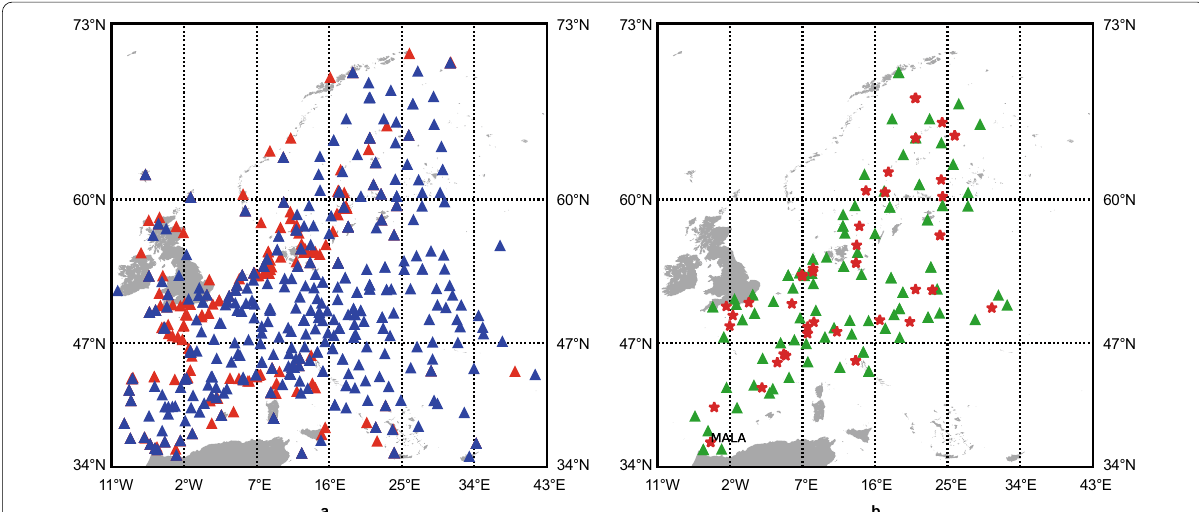
Fig. 2 The EPN [blue] and SONEL [red] networks in Europe provide PPP-RTK service in ( a ). In this study, they are mainly used to generate the ionosphere precision map and regional troposphere model. The red stars denote for assessing the PPP-RTK performance and the green triangles denote for the nearby reference stations in ( b ) which provide the interpolated ionosphere for the user stations